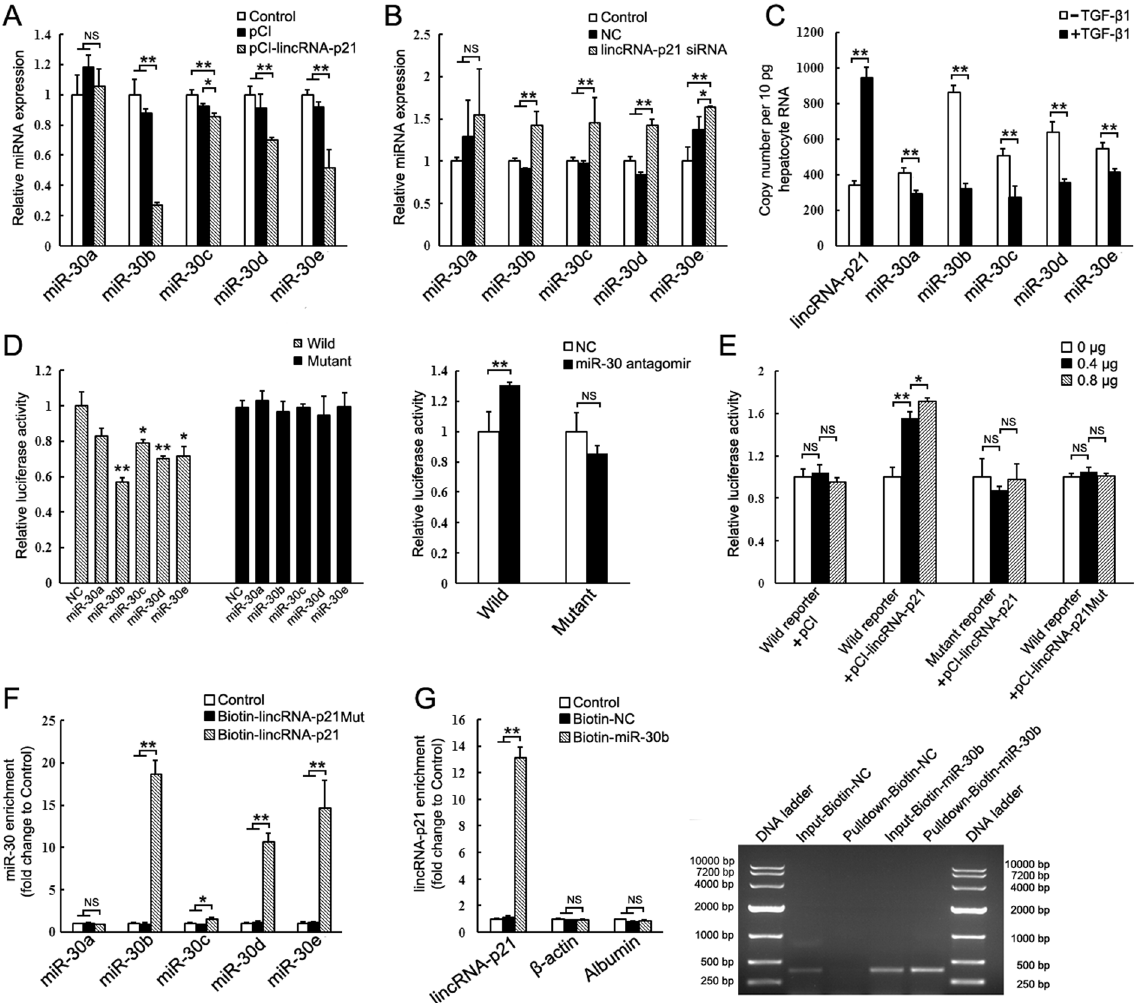
Figure 2. LincRNA-p21 interacts with miR-30. ( A ) Relative expression of miR-30 in AML12 cells transfected with pCI-lincRNA-p21 for 24 h. ( B ) Relative expression of miR-30 in AML12 cells transfected with lincRNA-p21 siRNA for 24 h. miR-30 levels were normalized against U6 snRNA unless noted otherwise in this study. The results are shown as fold change compared with control. ( C ) The copy numbers of lincRNA-p21 and miR-30 in AML12 cells treated with or without TGF- β 1 were quantified. ( D ) Analysis of luciferase activity in AML12 cells cotransfected with indicated luciferase reporters containing wild or mutant lincRNA-p21 cDNA, and miR-30 mimics or miR-30 antagomir. ( E ) Wild type or mutant luciferase reporter was transfected into AML12 cells, together with 0, 0.4 or 0.8 μ g of pCI-lincRNA-p21 or pCI-lincRNA-p21Mut. ( F ) miR-30 is associated with lincRNA-p21. AML12 cells were harvested and mixed with biotinylated lincRNA-p21 (Biotin- lincRNA-p21) or biotinylated lincRNA-p21 Mutant (Biotin- lincRNA-p21Mut) to perform biotin-based pull down. miR-30 enrichment was determined by qRT-PCR and normalized to control. ( G ) lincRNA-p21 is associated with miR-30. AML12 cells were transfected with biotinylated miR-30b (Biotin-miR-30b) or its biotinylated mimic control (Biotin-NC) for 24 h. Cells were then harvested for biotin-based pull-down. After washing and enrichment of beads/RNA complex, RNA was eluted from the streptavidin beads. Left, lincRNA-p21 enrichment was determined by qRT-PCR and normalized to control without any transfection. Right, Eluted RNA was amplified by RT-PCR with oligonucleotides spanning region of lincRNA-p21 and run on 1% agarose gel. Total inputs (Input-Biotin-NC and Input-Biotin-miR-30b) are indicated as total RNA isolated from Biotin-NC or Biotin-miR-30b-transfected AML12 cells. The results are shown as fold change compared with control group. Data are the mean ± SEM of three independent experiments. * P < 0.05, ** P < 0.01. NS, no significant